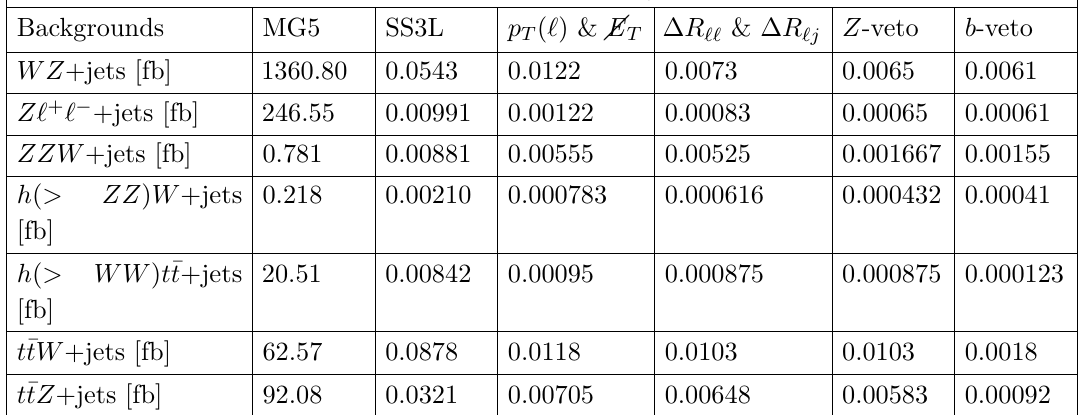
Table 3 . Effects of the selection cuts on the cross-sections for the dominant backgrounds of SS3L √ at s = 13 TeV